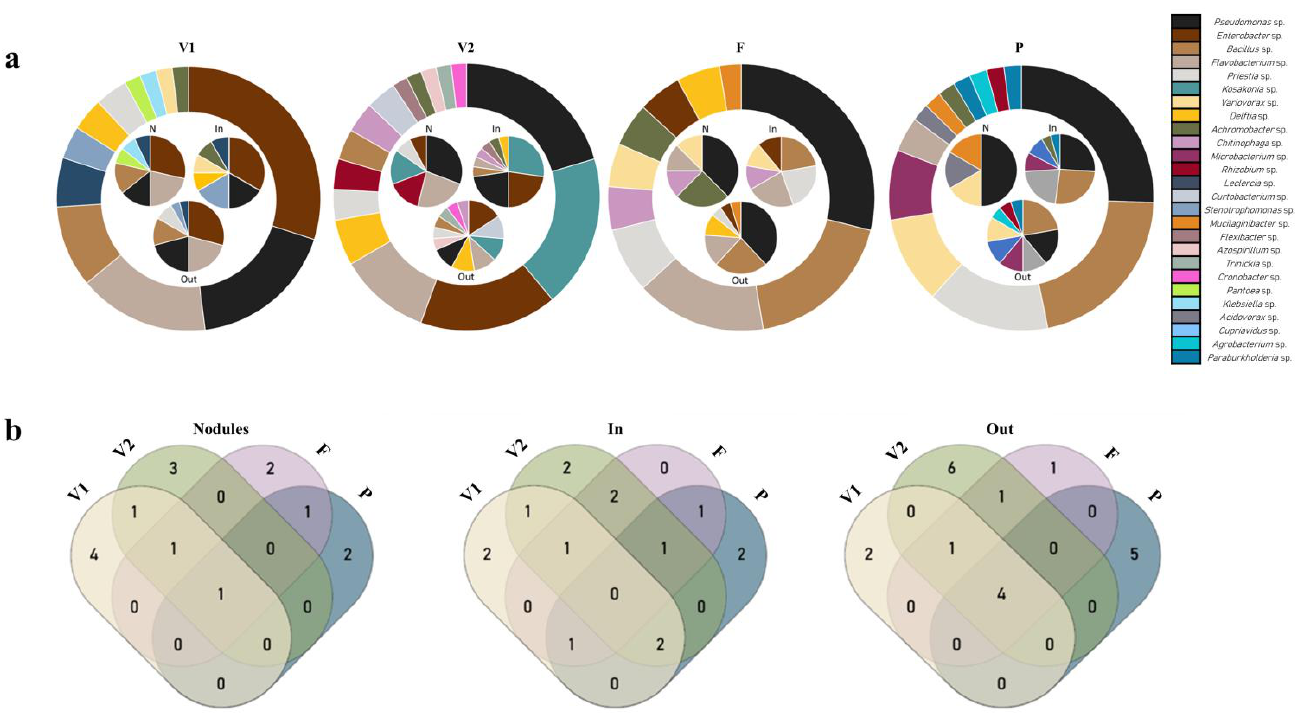
Figure 2. Specific distribution of bacterial genera. ( a ) Circle charts showing the distribution of bacterial genera according to plant development stage (outer circle) and root compartment (inner circles). Plant development stages: beginning of the vegetative stage (V1), end of the vegetative stage (V2), flowering stage (F), and pod stage (P). Root compartments: nodules (N), inside roots